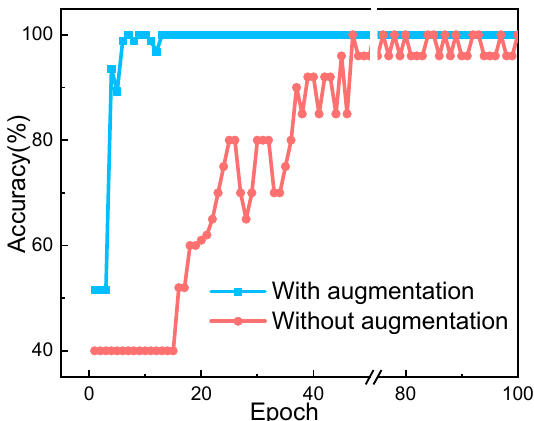
Figure 5. Comparison of accuracy on test set with and without augmentation in one-fold, where augmentation rendered the convergence faster and smoother.